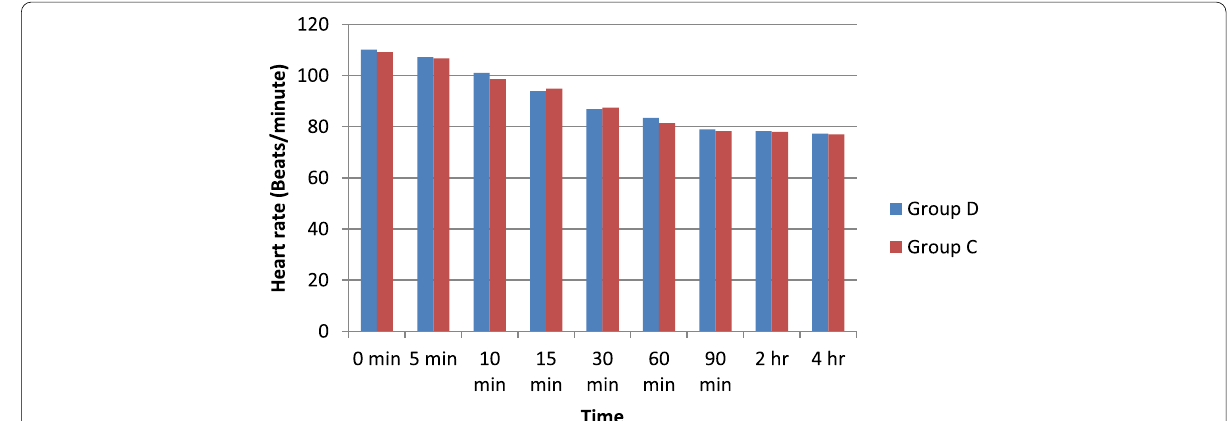
Fig. 4 Comparison of heart rate at different time intervals in both the groups